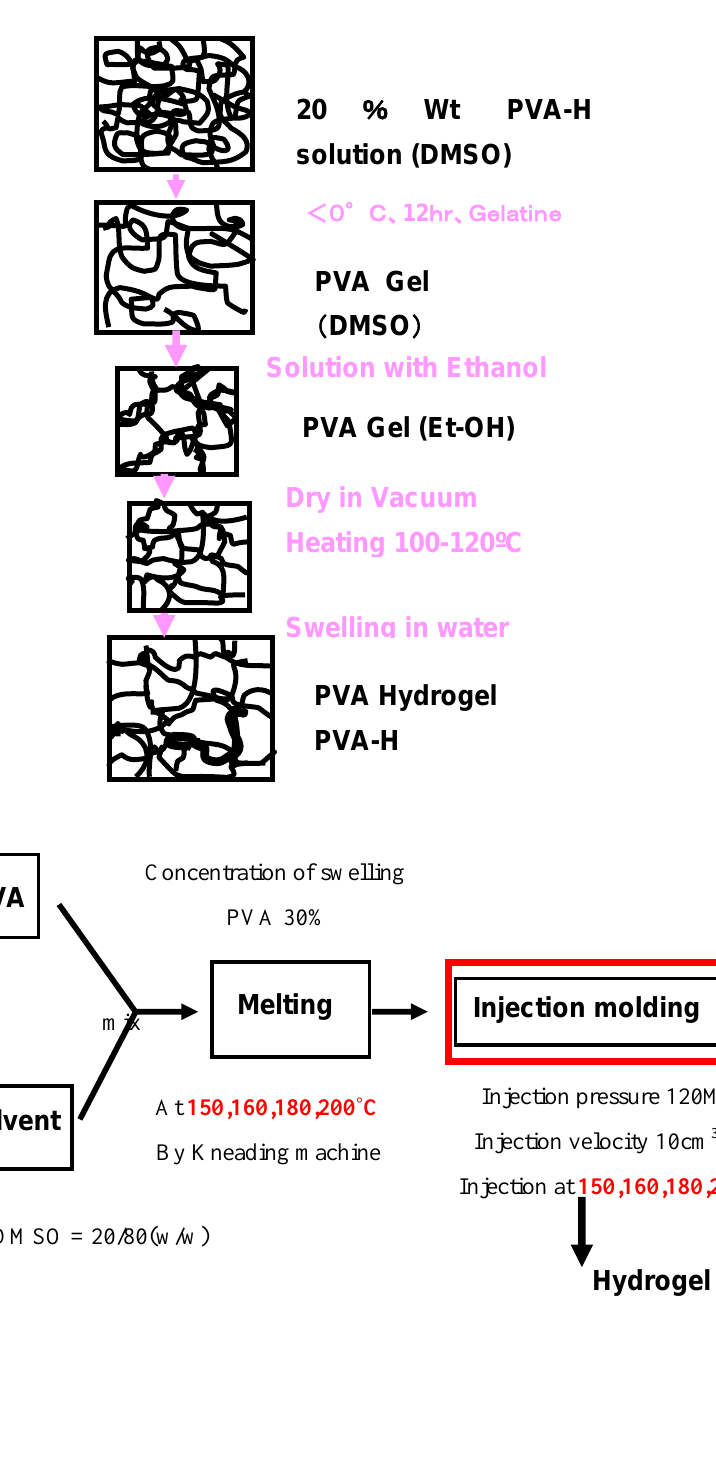
Figure 1. (a) Flow chart of the production process of Polyvinyl alcohol-hydrogel (PVA-H) by freeze-thaw method. (b) by injection molding